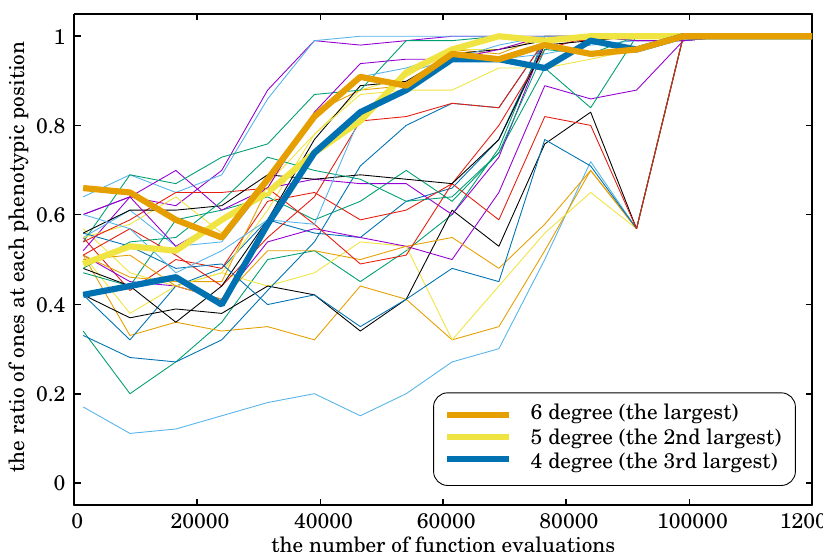
Figure 9. The convergence curve of phenotypic values corresponding to the nodes with the three larger degrees when solving